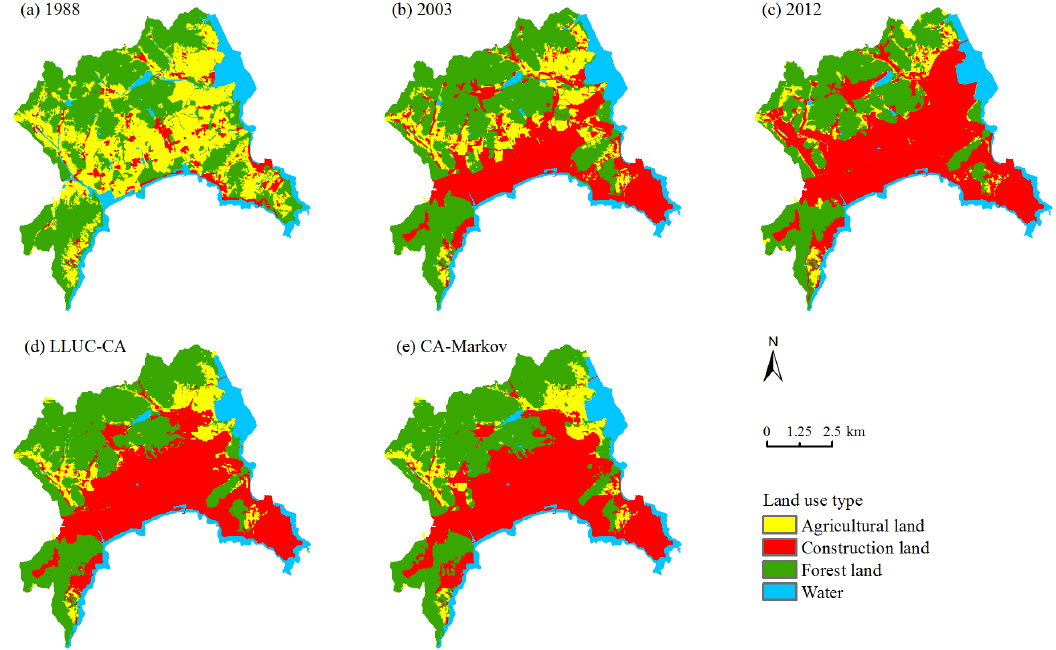
Figure 7. Land use maps: ( a ) actual land use map in 1988; ( b ) actual land use map in 2003; ( c ) actual land use map in 2012; ( d ) LLUC-CA simulated land use map in 2012; and ( e ) CA-Markov simulated land use map in 2012.